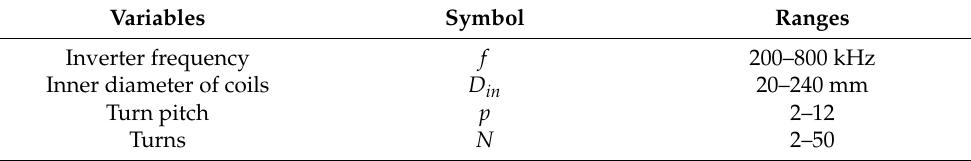
Table 1. The final design variables and